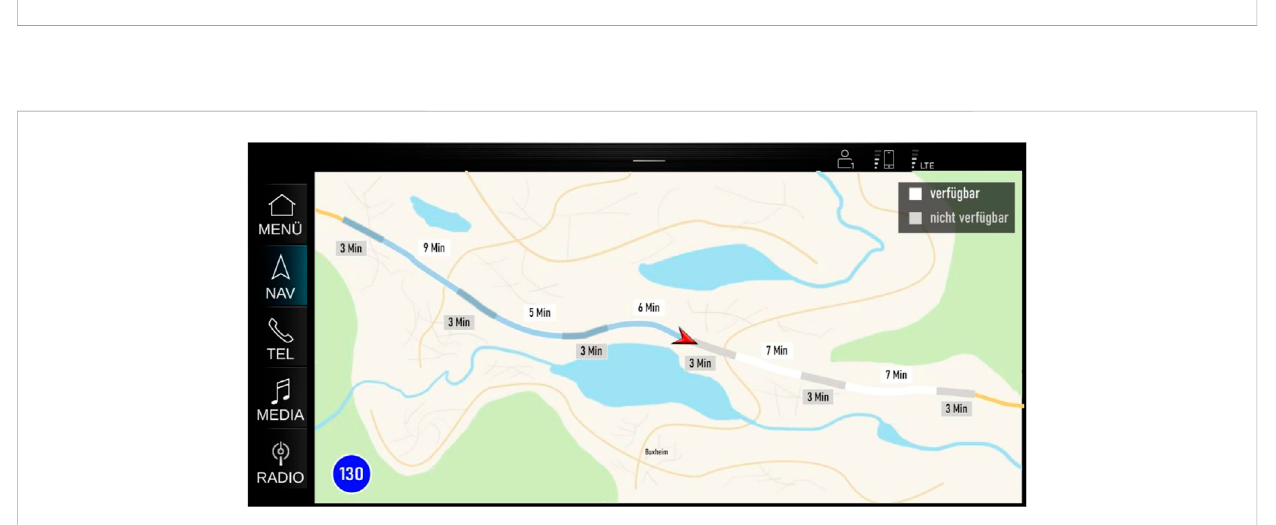
FIGURE 4 MC, providing information on the availability sections on the map.